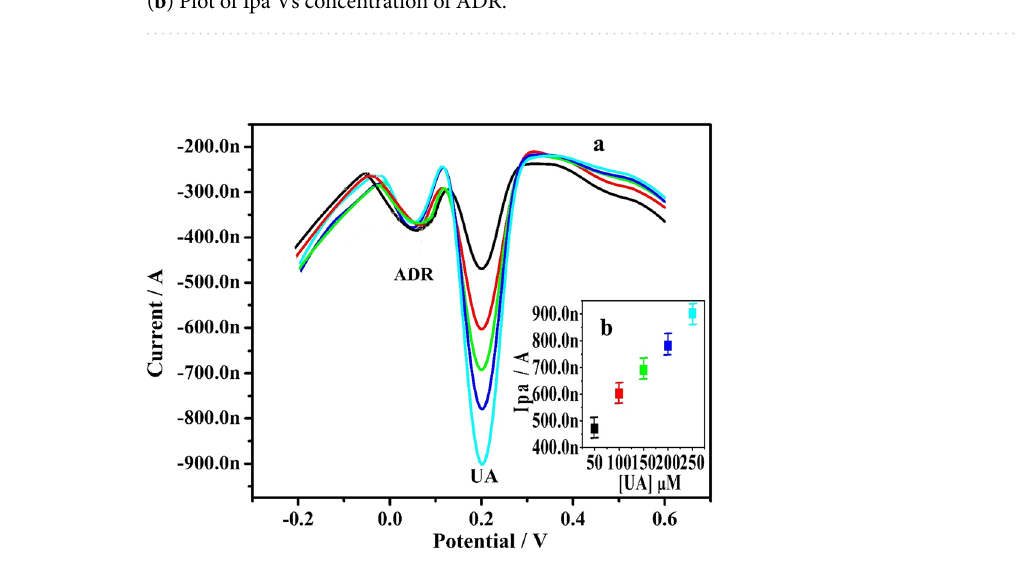
Figure 11. ( a ) DPVs of UA at altered concentrations (50–300 µM) in 0.2 M PBS (7.4 pH) on Po-ERY/MGPE. ( b ) Plot of Ipa vs concentration of